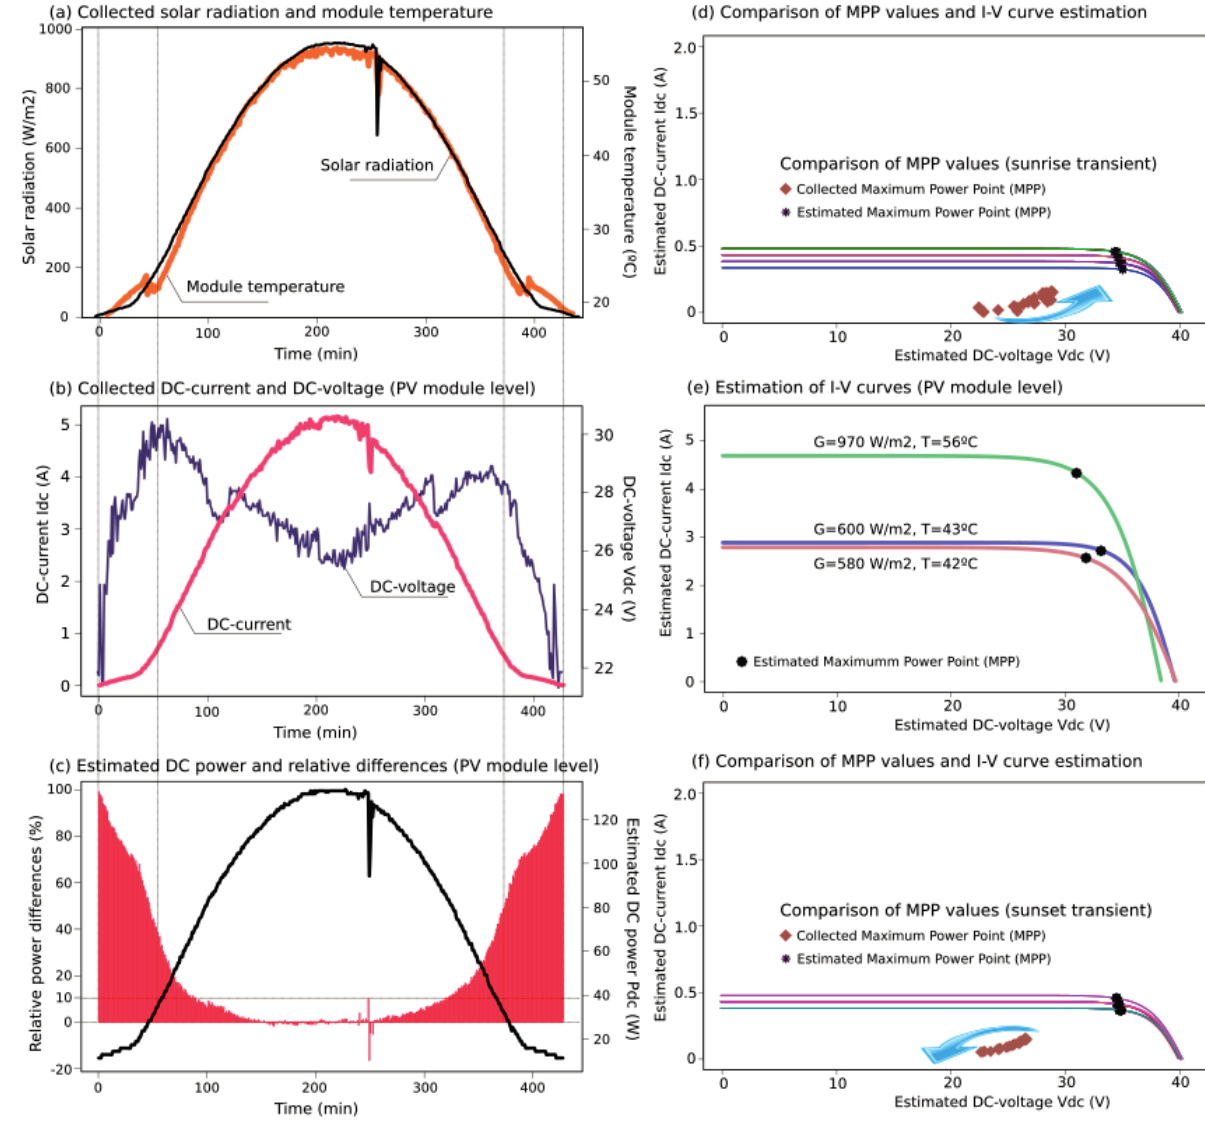
Figure 14. Case Study II: collected data ( a , b ); estimations of DC power ( c ), and I - V curves at the PV module level ( d – f